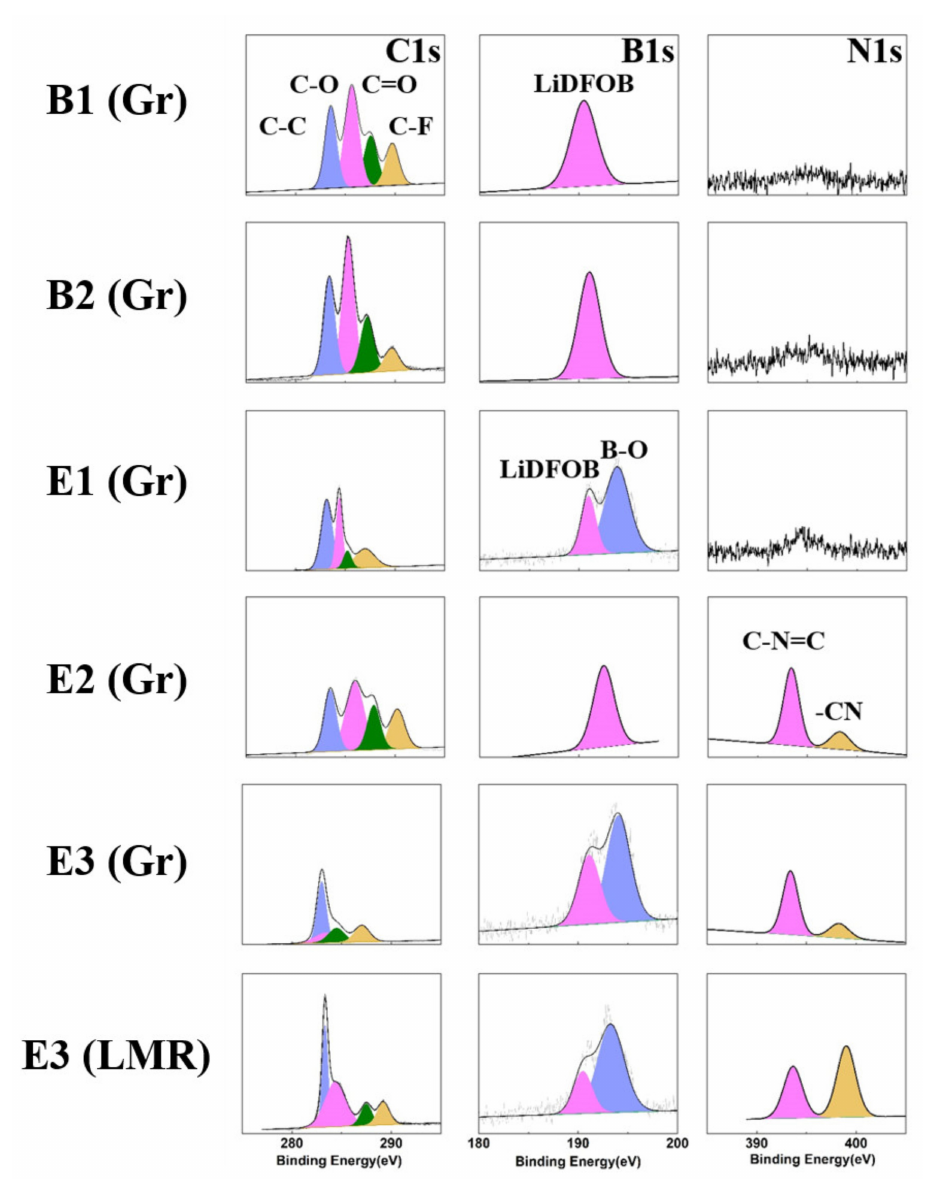
Figure 6. XPS analyses of different electrolytes on graphite anodes and LMR